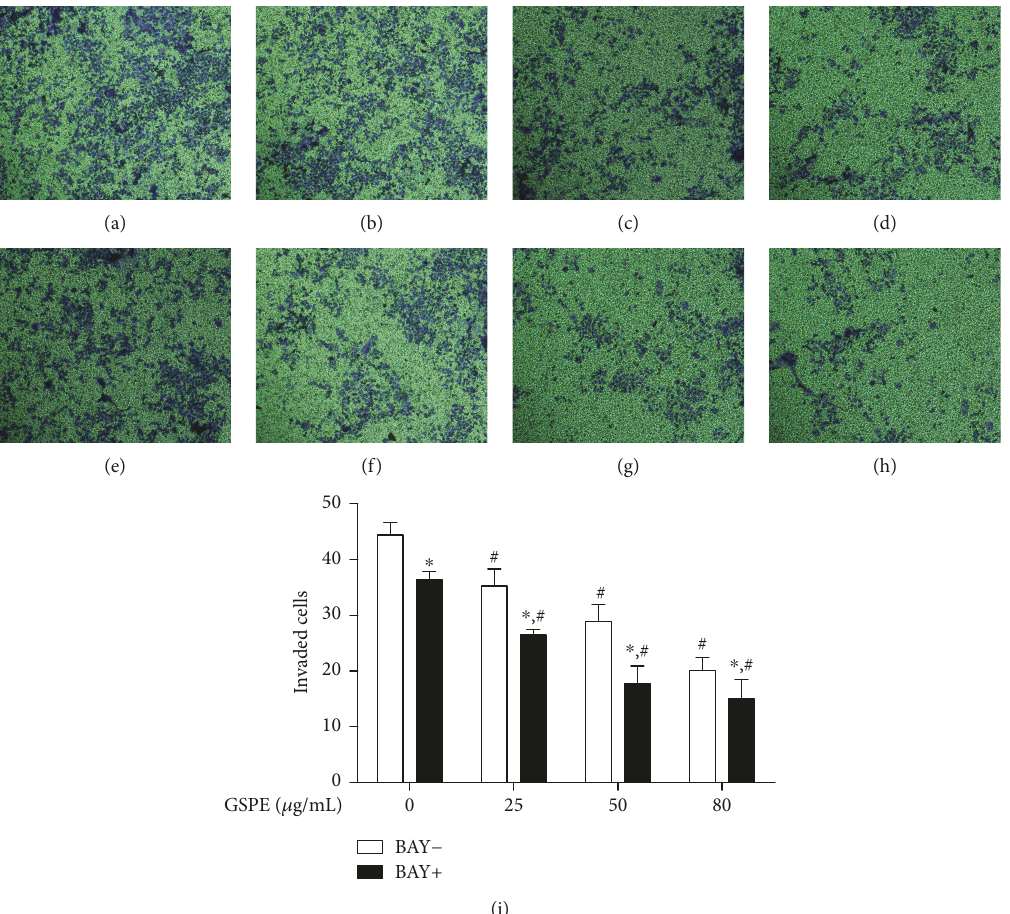
Figure 4: The e ff ect of GSPE and BAY11-7082 on the invasion ability of ECA109 cells. The e ff ect of GSPE on ECA109 invasion was analyzed by using Transwell assay. Each treatment was assayed in triplicate. After incubation at 37 ° C for 24h, the cells were observed by an inverted microscope (magni fi cation, × 100). (a – d) The inhibition of invasion ability in cells induced by GSPE (0 – 80 μ g/mL). (e – h) The inhibition of invasion ability in cells induced by GSPE (0 – 80 μ g/mL) + BAY11-7082. (i) The number of invaded cells, which was evaluated by ImageJ 2x. Each column represents mean ± SD of three groups of independent samples. ∗ P < 0 05 compared with the BAY11-7082 group; # P < 0 05 compared with the GSPE 0 group.